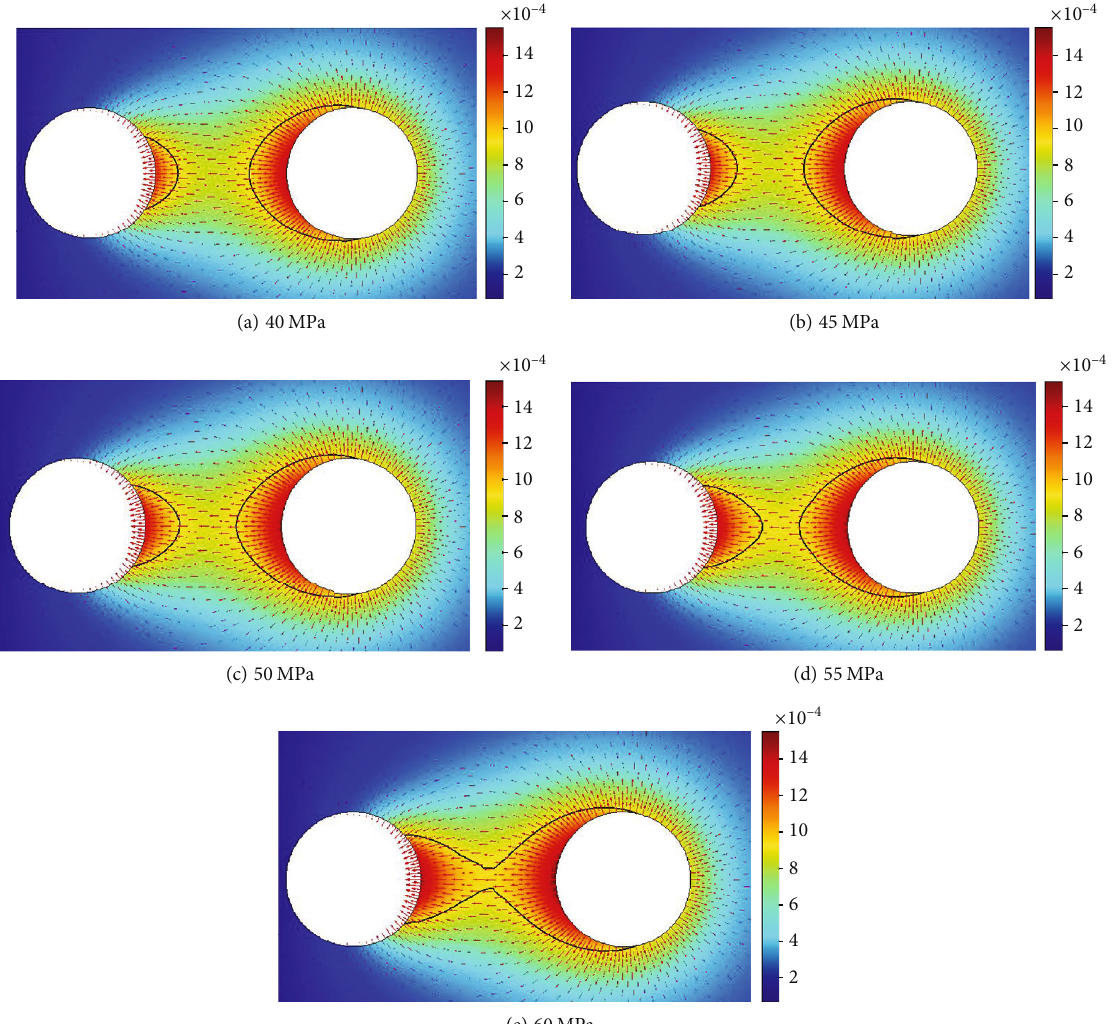
Figure 8: Velocity distribution after excavation of di ff erent explosion loads (unit: m/s).